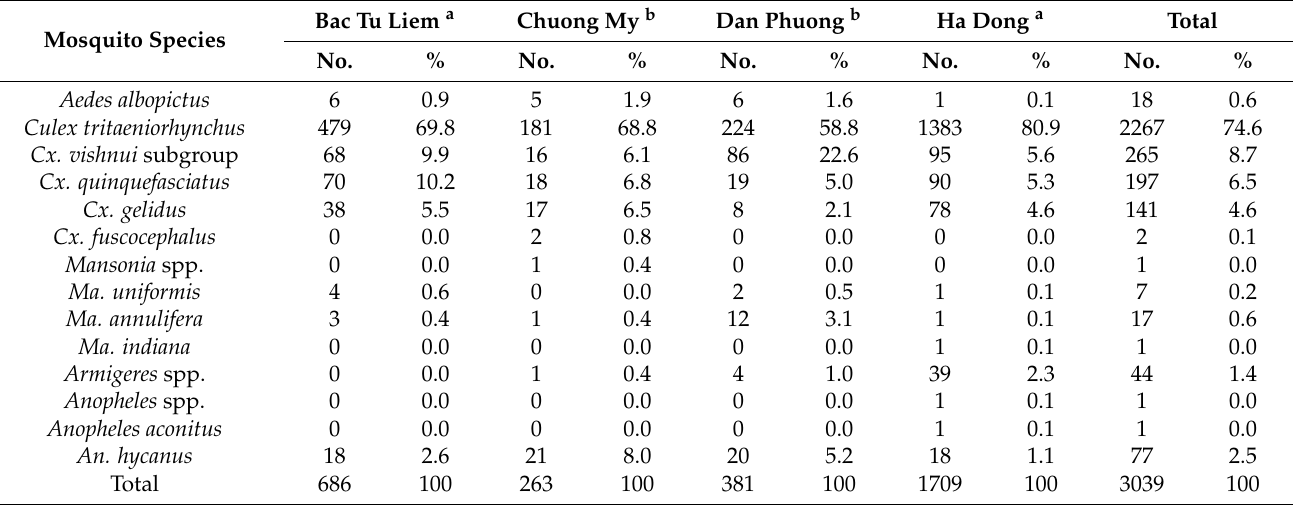
Table 6. Summary of mosquito species collected at bedroom—indoor.